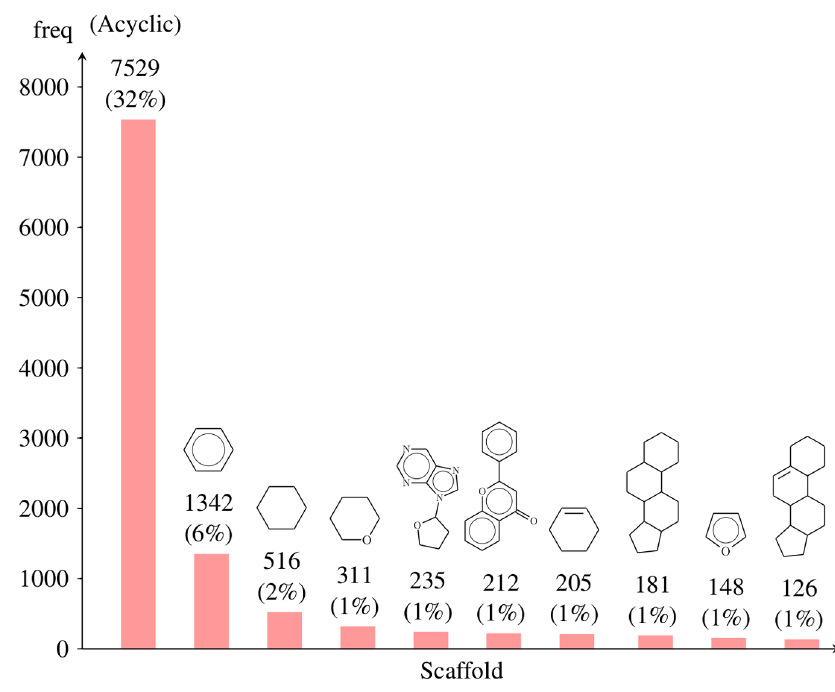
Figure 3. Frequency of the ten most common scaffolds in